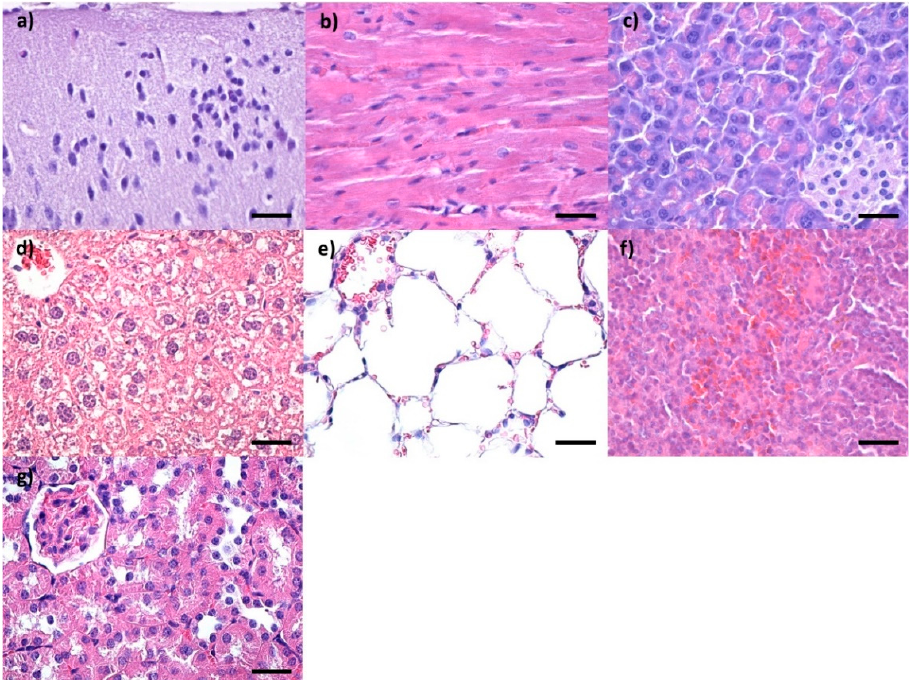
Figure 2. Cross-section through ( a ) brain, ( b ) myocardium, ( c ) pancreas, ( d ) liver, ( e ) lungs, ( f ) spleen and ( g ) kidney from control mice injected with saline solution and harvested at 2 days after intravenous administration; normal morphology; Hematoxylin–Eosin staining; 400× magnification, scale bar 50 μ m.